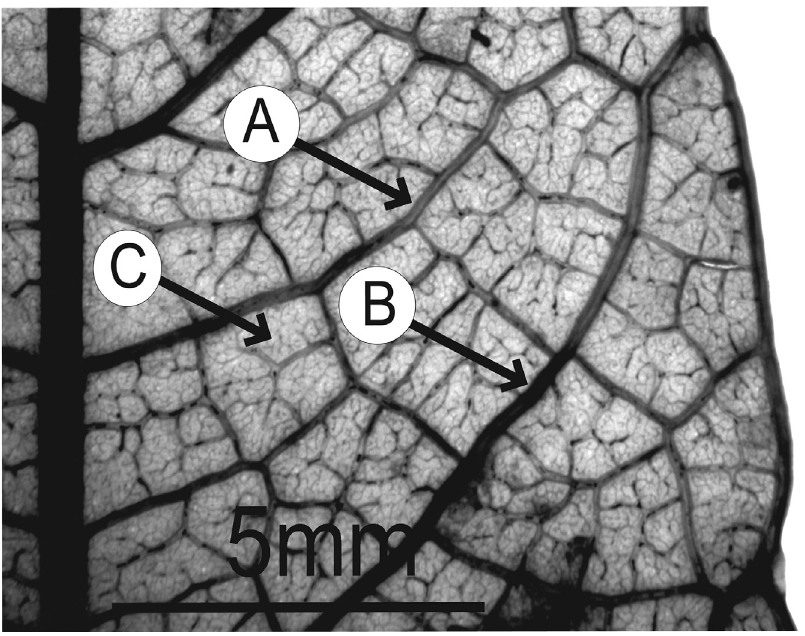
Figure 5. Leaf architecture of Spondias radlkoferi. A Intersecondary vein B Arcuate secondary C Area of highly branched sclereids (from Mitchell 120 , NY).